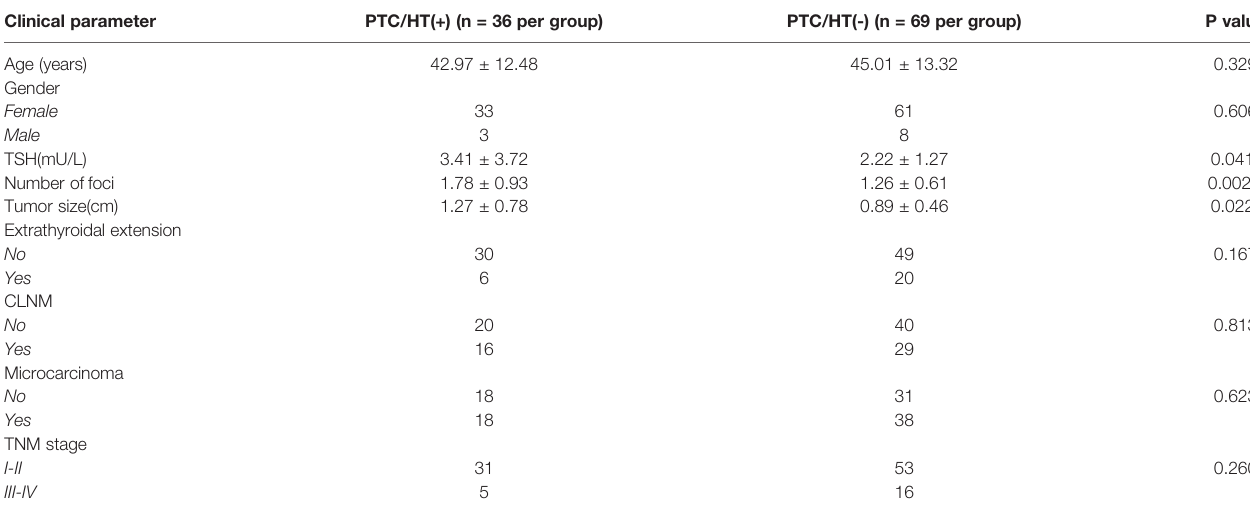
TABLE 1 | The demographic and clinical characteristics of the enrolled patients. Clinical